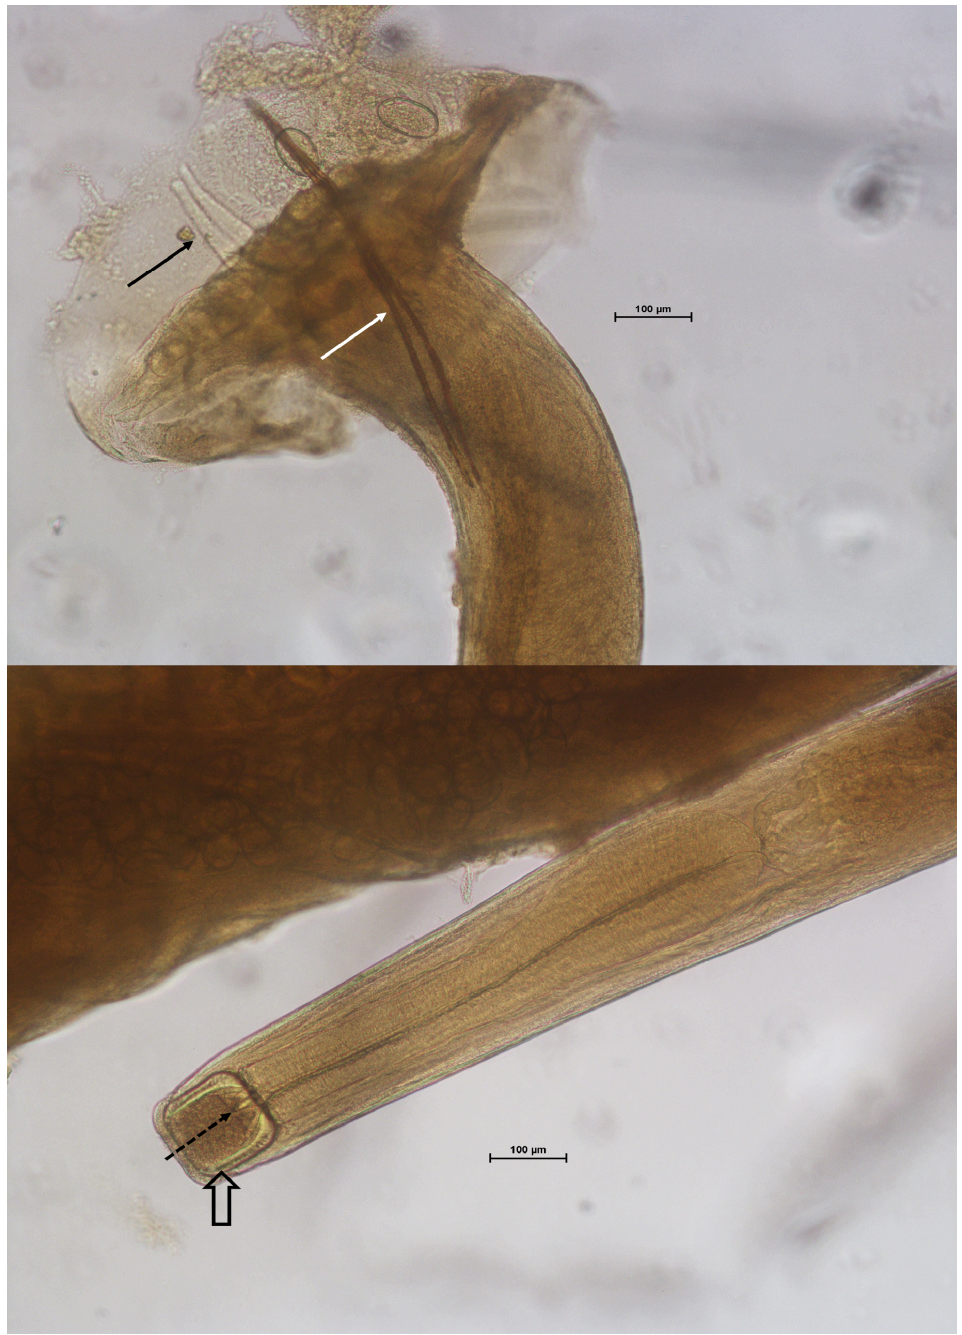
Figure 3. Microscopic view of the tail and head of C. bronchialis male. Black arrow: branched dorsal ray; white arrow: spicules; empty arrow: buccal capsule; dotted arrow: buccal teeth. Unit is 100 µ